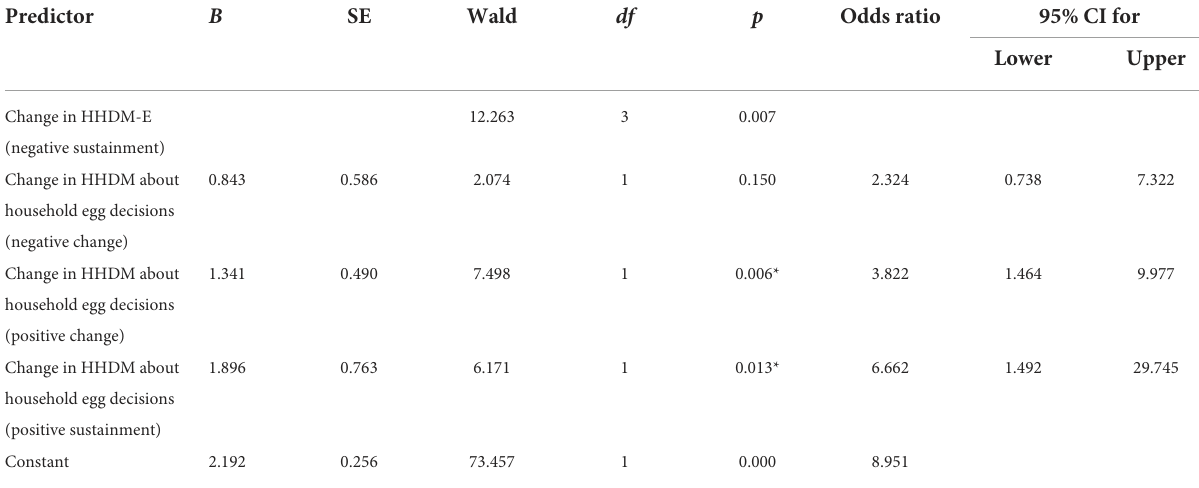
TABLE 5 Logistic regression results for egg consumption based on change in HHDM-E from baseline to endline. Logistic regression predicting likelihood of egg consumption based on change in HHDM-E from baseline to